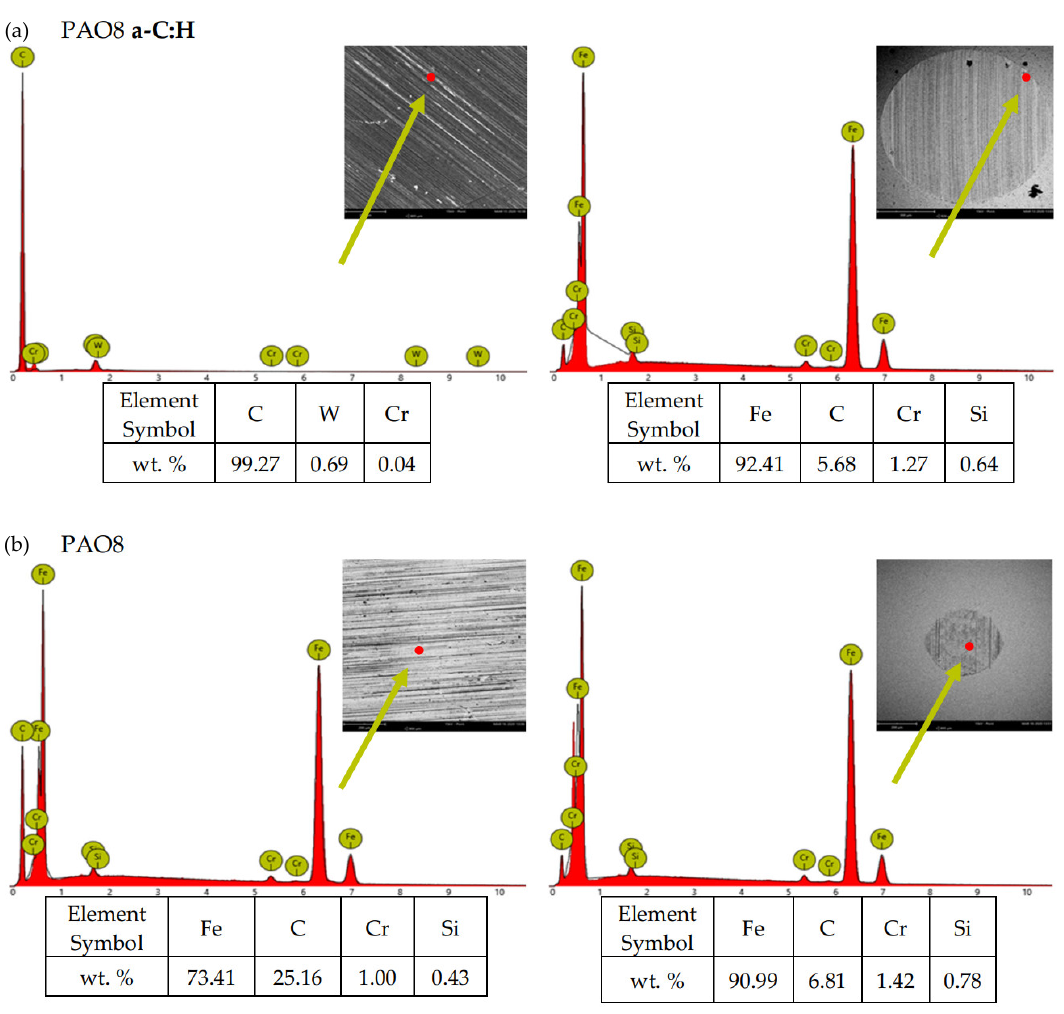
Figure 10. EDS patterns for different points of the wear track resulting from the sliding contact of the ( a ) coated and ( b ) uncoated steel discs with the steel balls—lubricant: PAO8.